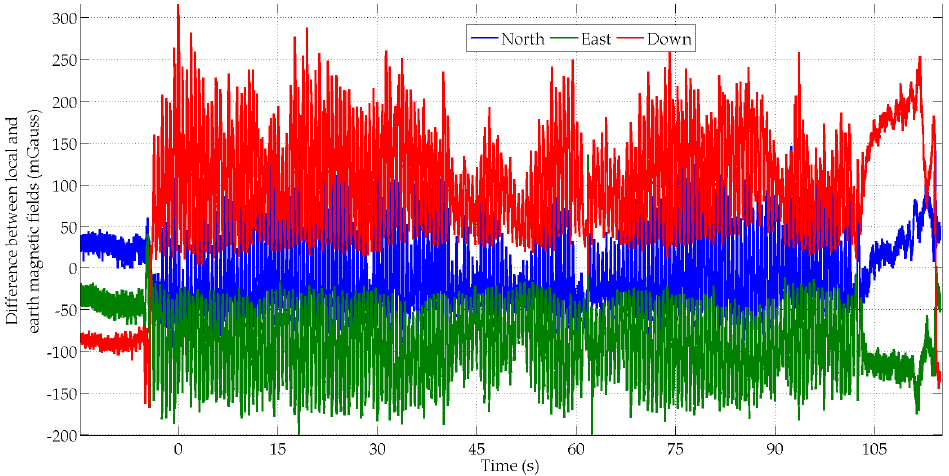
Figure 8 . Difference between two magnetic field vectors, i.e. , the Earth field and the MIMU’s field, for subject S4 in the swinging scenario.